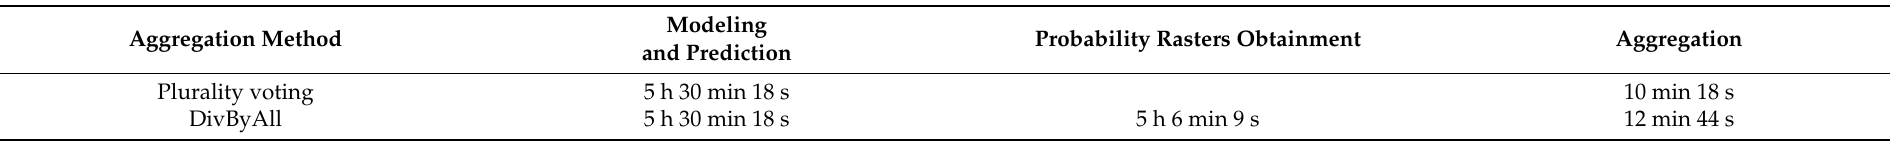
Table 7. The processing time to obtain the TNH land cover classification using the two different aggregation methods (Plurality voting and DivByAll).